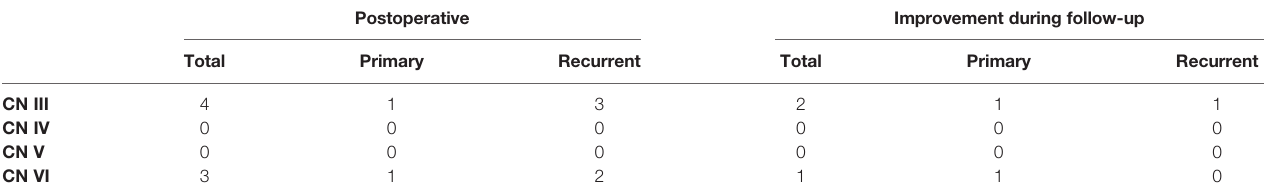
TABLE 5 | Complications of cranial nerve